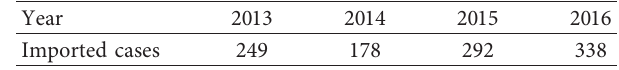
Table 1: Numbers of imported